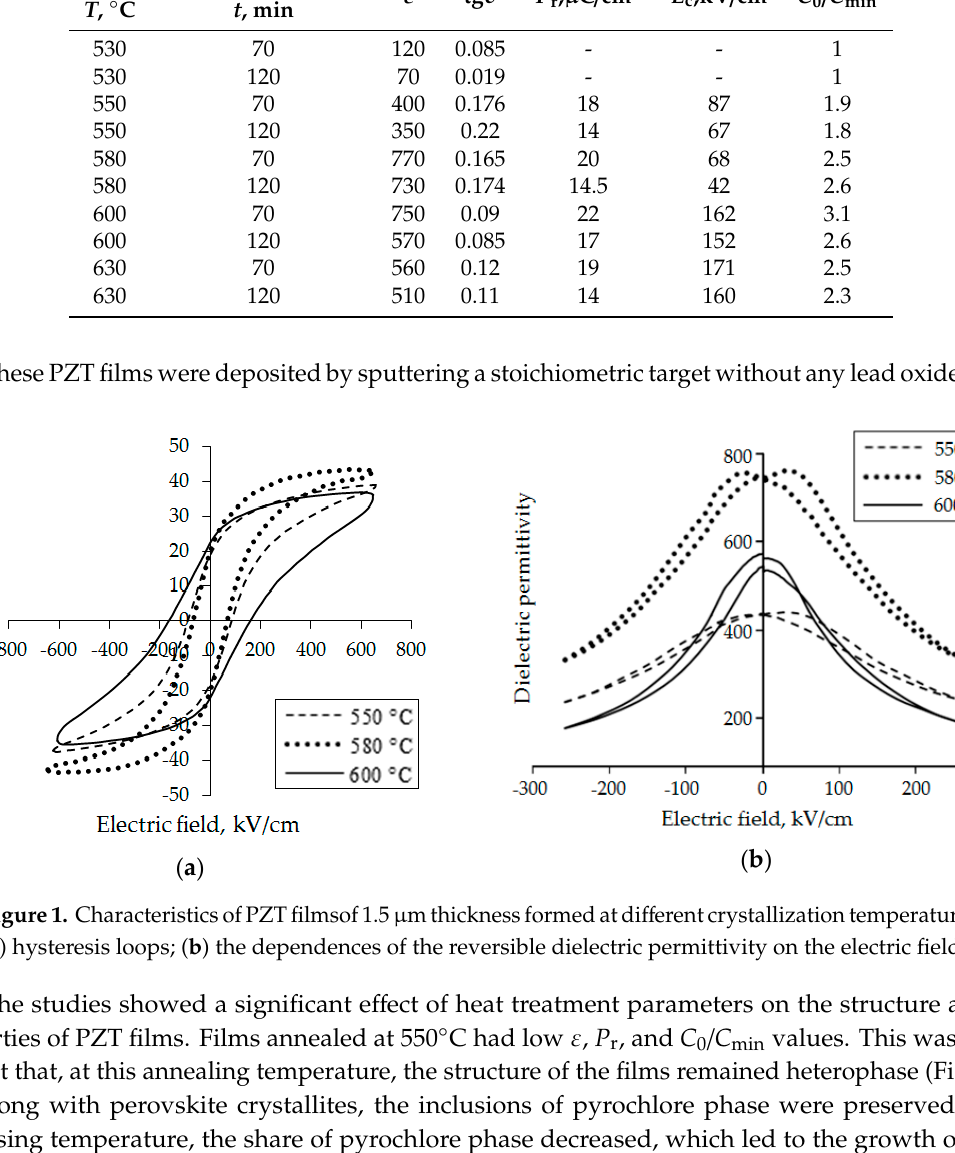
Table 2. Electro-physical parameters of PZT films. 135